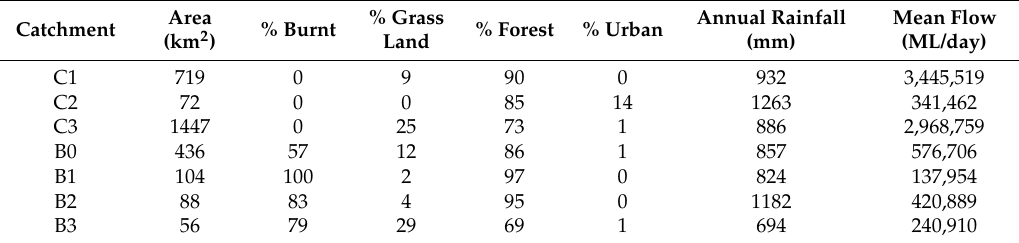
Figure 1. Study area. Table 2. Catchment characteristics.